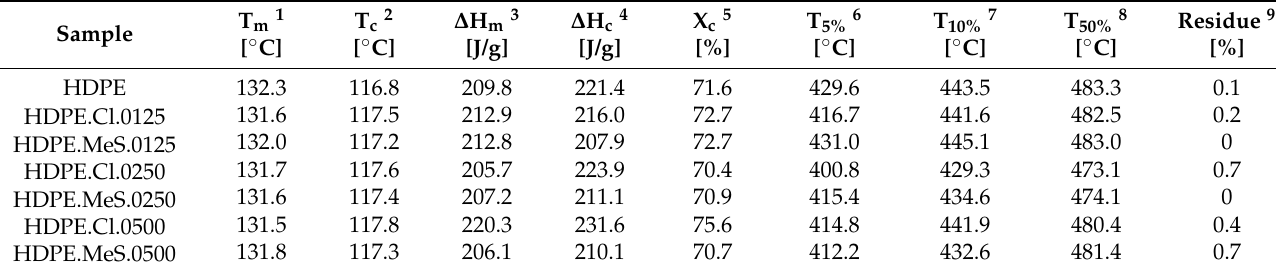
Figure 3. AFM images of HDPE, HDPE.Cl.0500, and HDPE.MeS.0500 (Ra = arithmetic mean roughness).